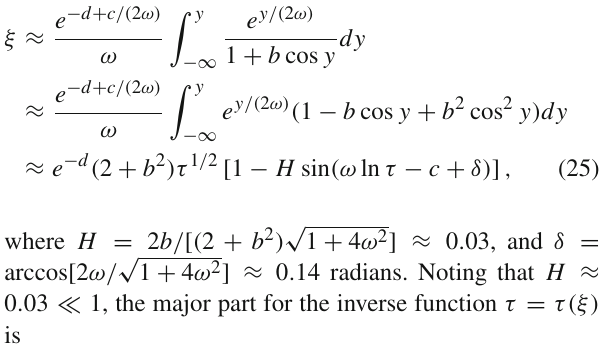
Fig. 6 Comparison of the numerical results of e − σ and r / x